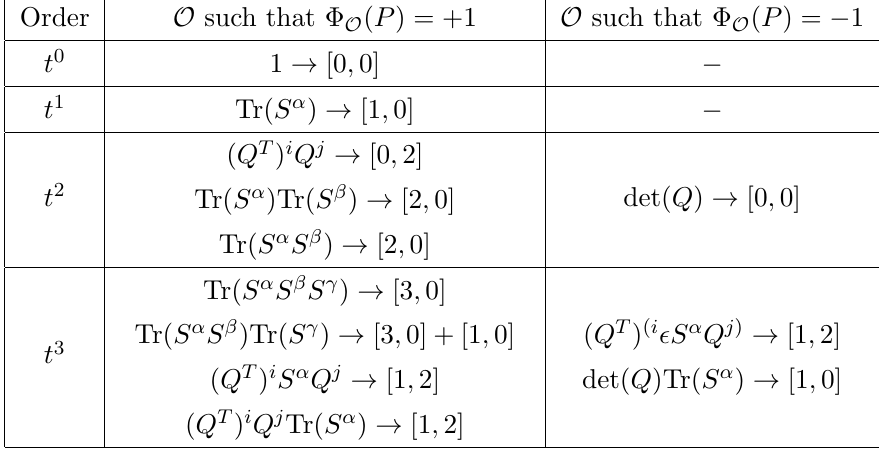
List of operators contributing to the Higgs branch Hilbert series for the SO(2) theory (columns 2 and 3) and for the O(2) theory (column 2